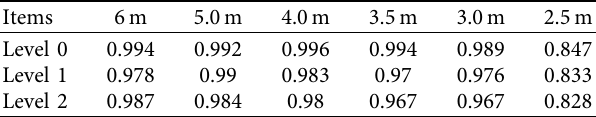
Table 7: Test results of arch bridge (tailwind, side).